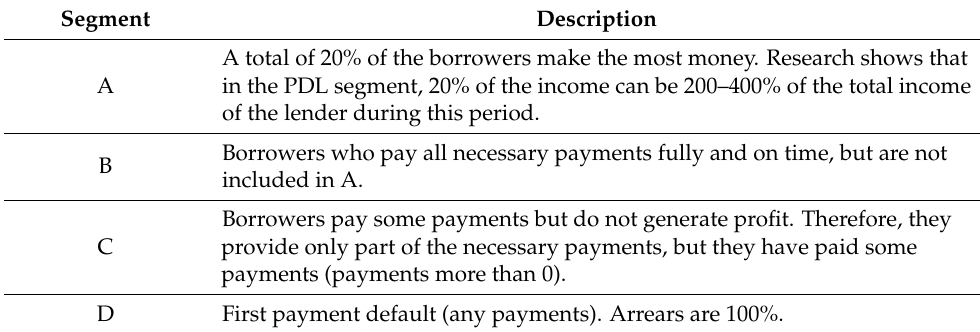
Table 1. Segments Table 1. Segments description.